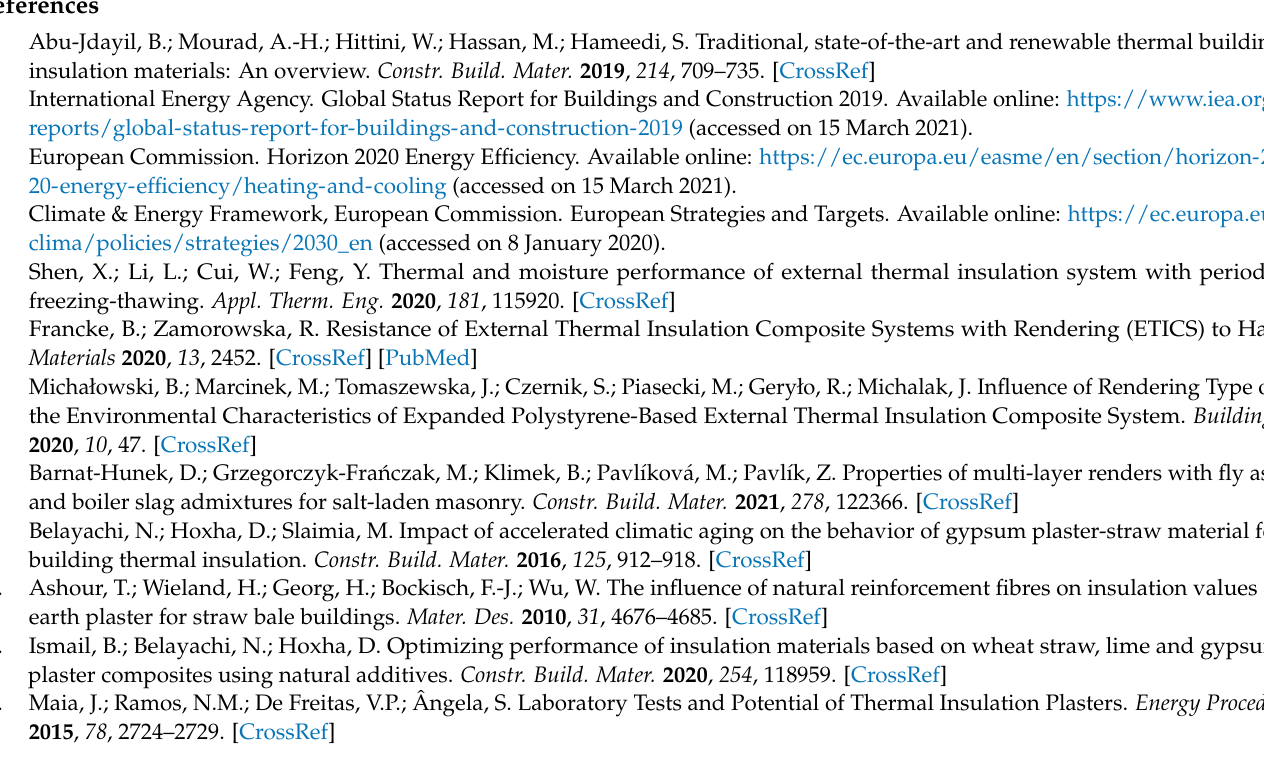
Figure S2: Photos of the researched plasters before and after salt crystallization test: ( a ) Plaster CLM1; ( b ) Plaster CLM2; ( c ) Plaster LGM, Table S1: The pore size distribution